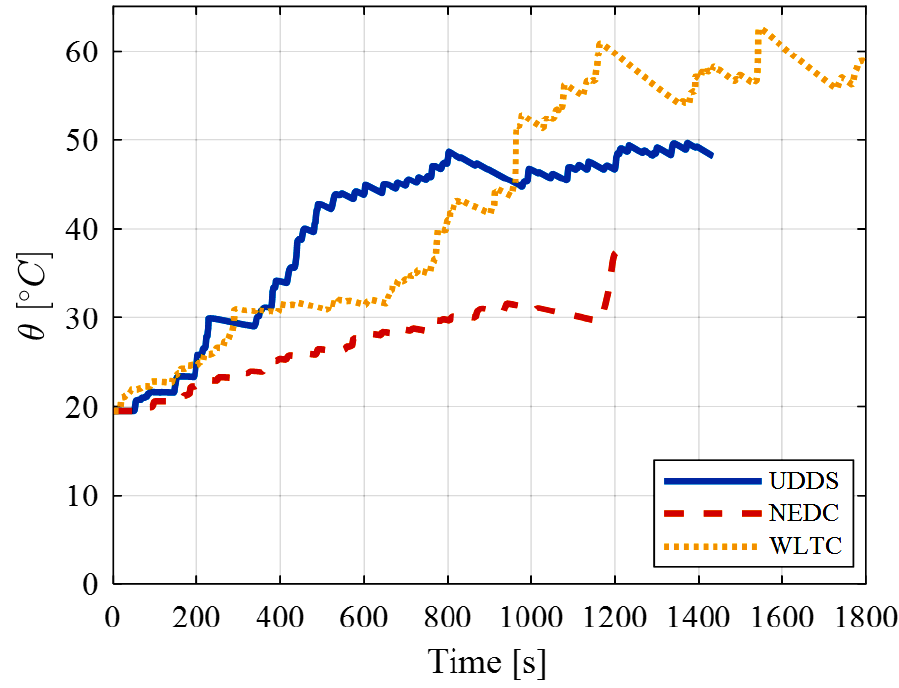
Figure 22. The temperature of the 14s12p battery pack on different driving cycles.